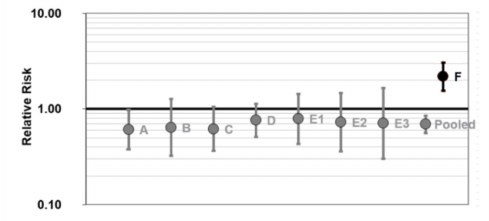
Figure A1. Plot of effect size estimates in Table